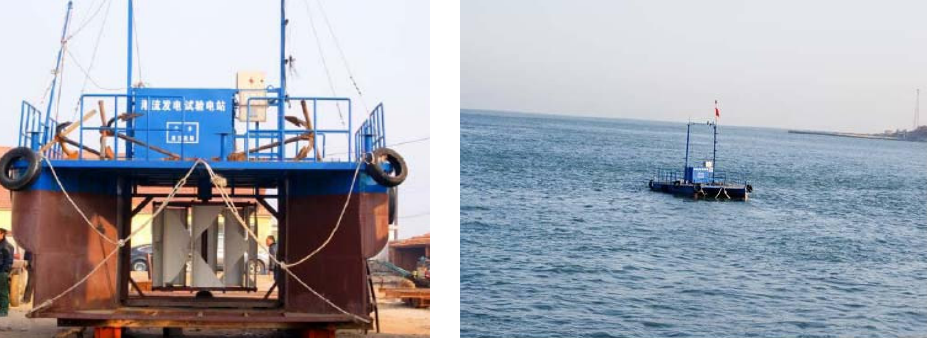
Figure 24. A 5 kW flexible blade TCPGS. Reproduced from [29,67].